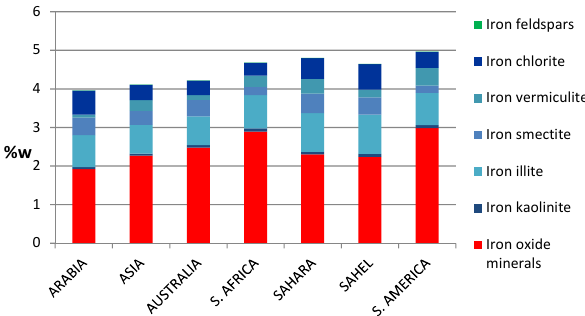
Fig. 9. Average iron content and speciation of the major dust-source regions (clay fraction, CASE 0).